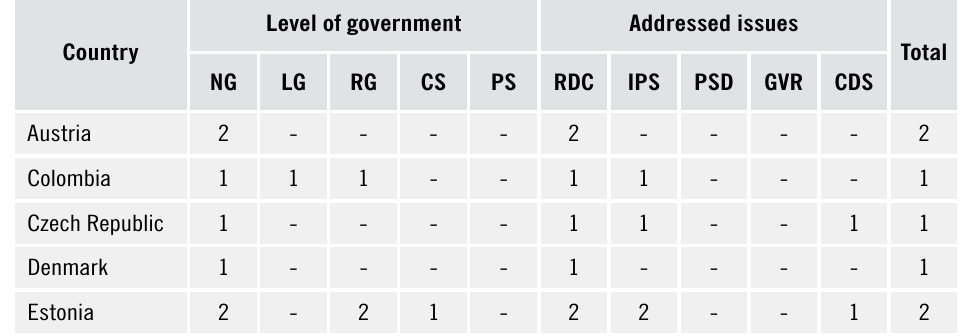
Table 2. Quantitative analysis of innovative solutions Level of government Addressed Country